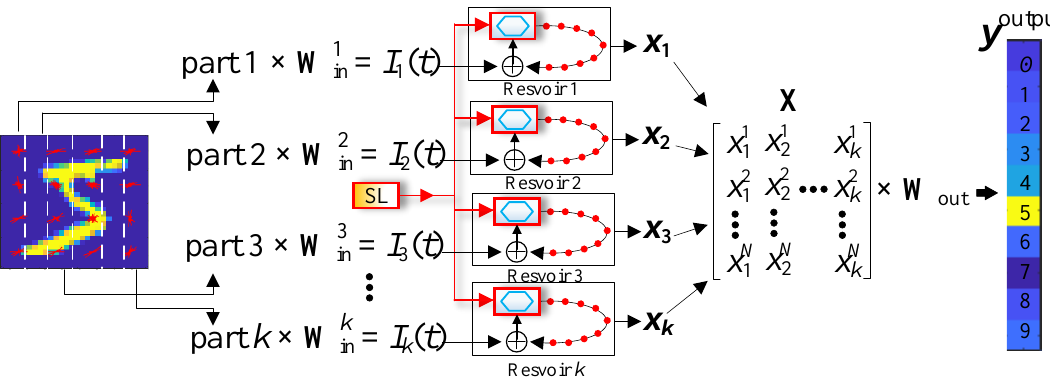
Figure 5. Schematic diagram of parallel processing based on multi-reservoirs.